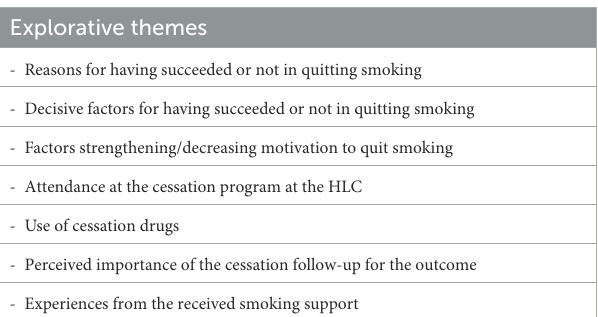
TABLE 1 Questions used in the semi-structured interview